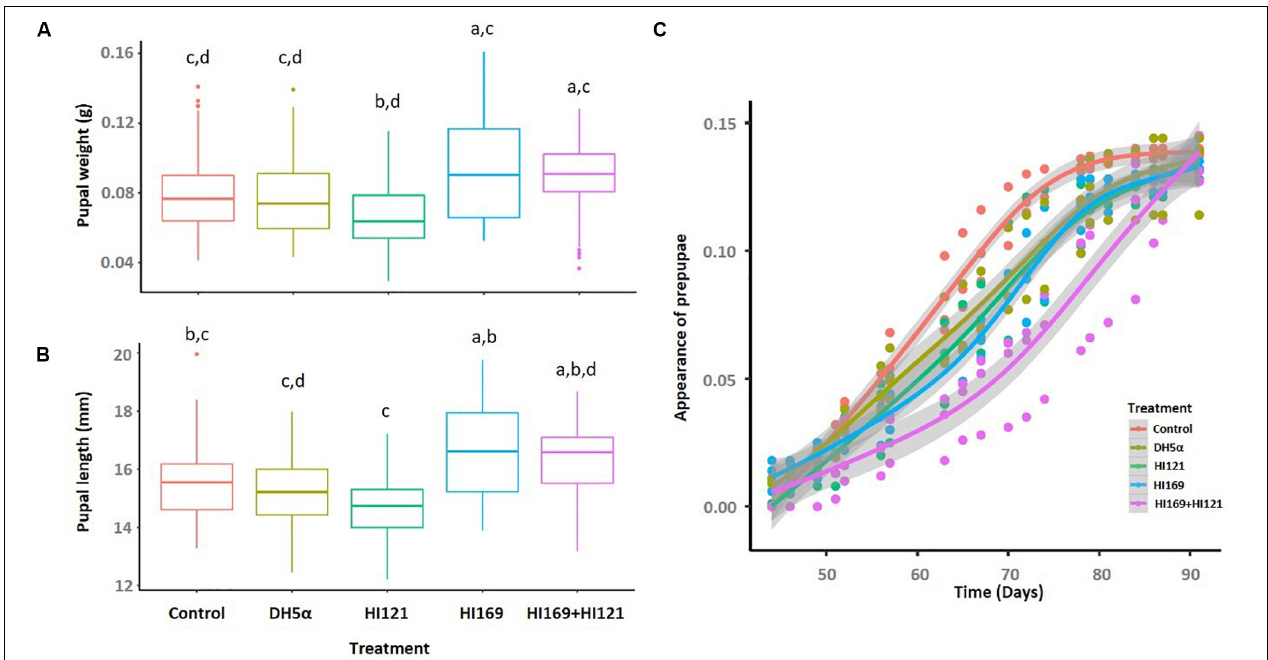
FIGURE 4 | Pupal weight, length and appearance following the bacterial administration. (A) Pupal weight and (B) length are depicted for the different treatments. (C) The prepupal appearance is reported as the progressive average percentages within the population of each treatment. Control: non-sterile diet without any selected strains; DH5 α : larvae fed with the outsider strain of E. coli DH5 α pKan(DsRed); HI121: larvae added with S. maltophilia strain HI121; HI169: larvae supplemented with B. licheniformis strain HI169; HI169 + HI121 larvae fed with the two selected